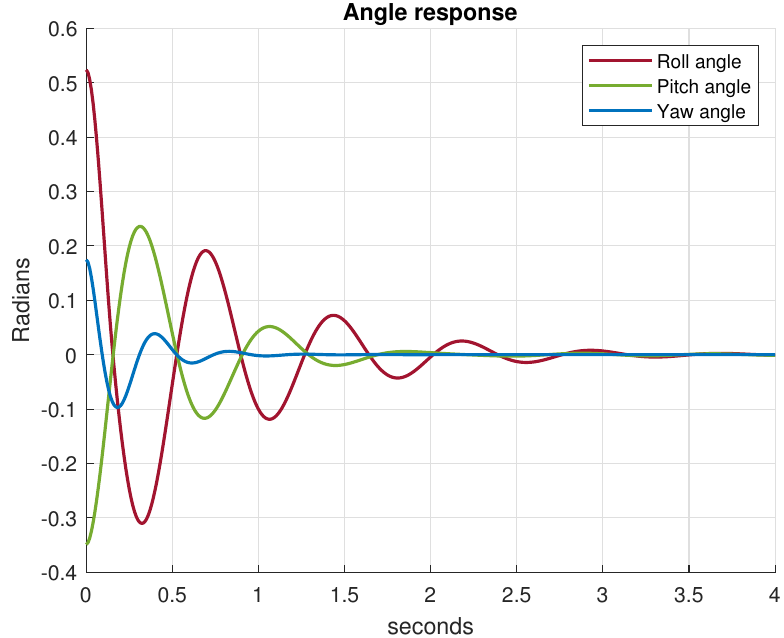
Figure 7. Euler angles during attitude